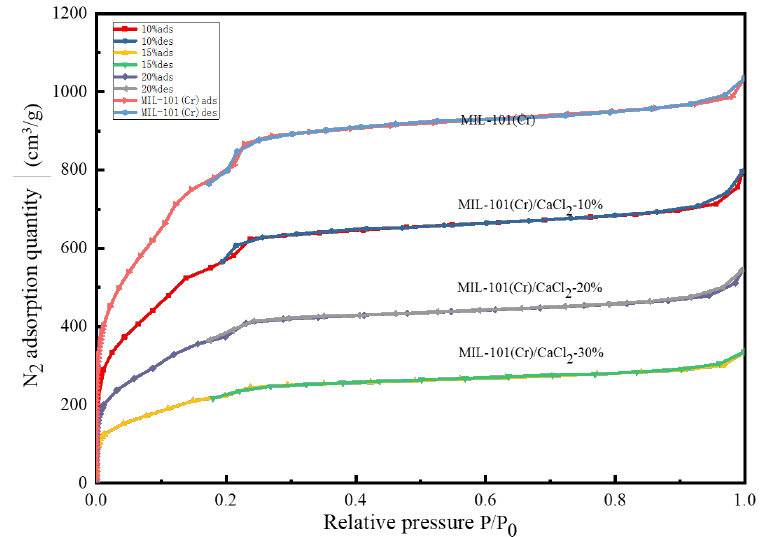
Figure 3. Nitrogen adsorption–desorption isotherms of MIL-101(Cr) and